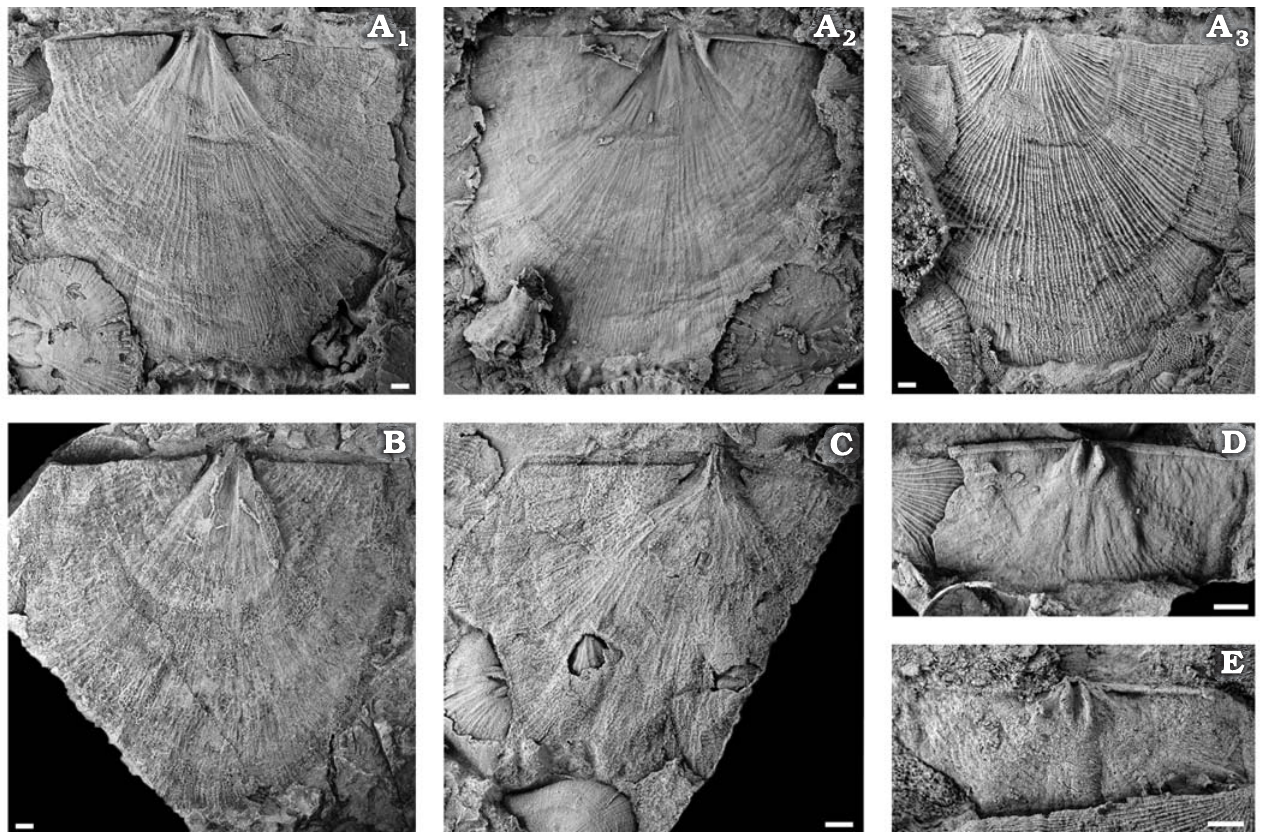
Fig. 19. Rafinesquinine brachiopod Rafinesquina ( Mesogeina )? sp. A; middle–upper Katian (Ka2–4), Upper Ordovician; Gabian Formation, Montagne Noire, France. A . MPZ 2015/1398, internal mould (A 1 ) and latex cast of interior (A 2 ) and exterior (A 3 ) of an almost complete ventral valve. B . MPZ 2015/1399, internal mould of ventral valve. C . MPZ 2015/1400, internal mould of ventral valve. D . MPZ 2015/1401, latex cast of interior of an incomplete dorsal valve. E . MPZ 2015/1402, latex cast of interior of an incomplete dorsal valve. Scale bars 2